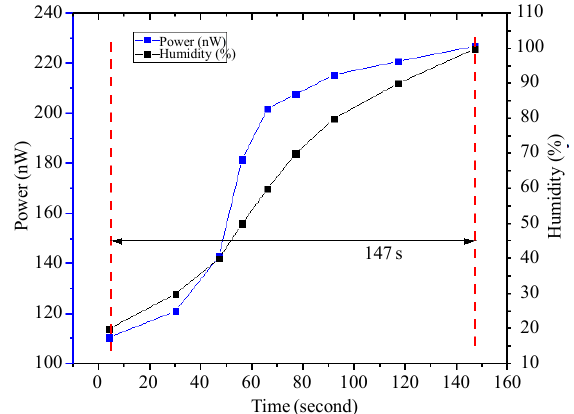
Fig. 13 Response time of the designated sensor.